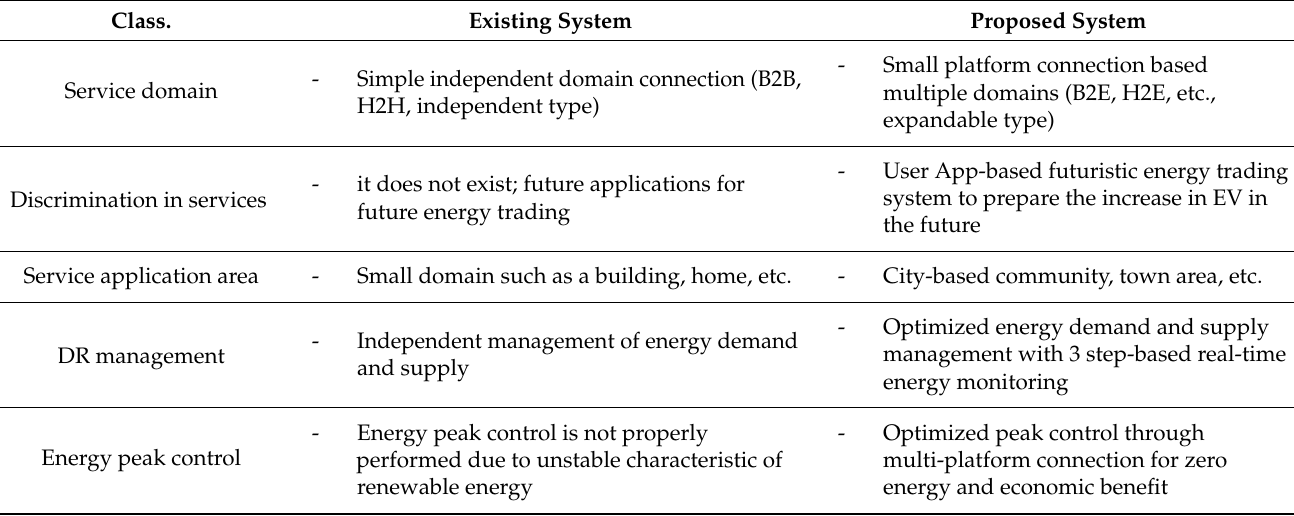
Table 1. Difference of Existing System and Proposed System.